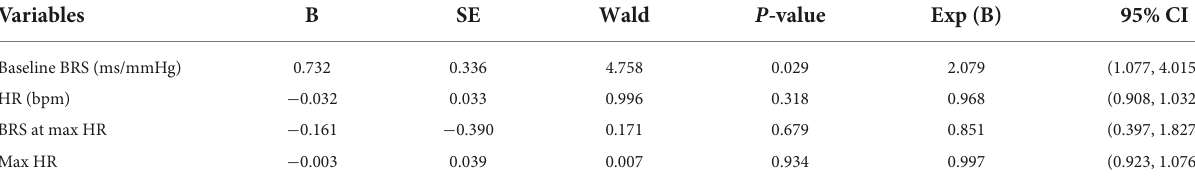
TABLE 2 Multivariable logistic regression analysis of therapeutic response to